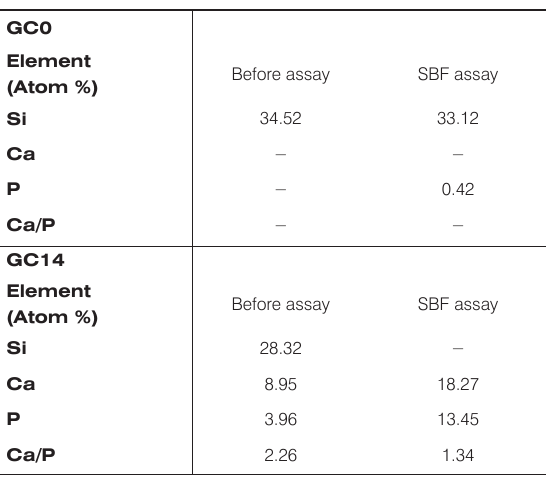
Table 4. Surface composition obtained by EPMA of glass ceramic samples before and after 7-day assay in